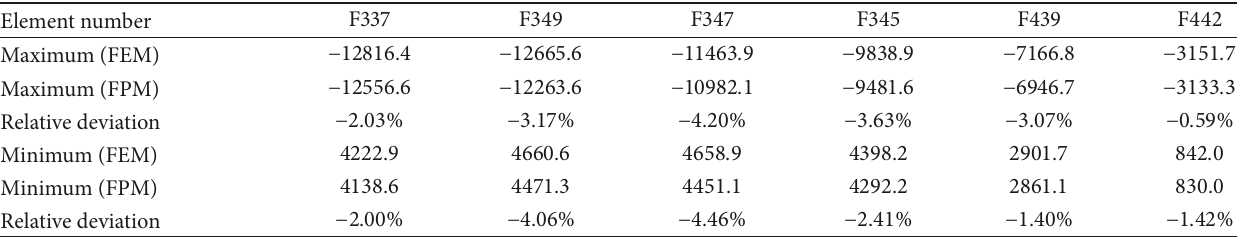
Table 5: Maximum and minimal axial force of some members of tower.